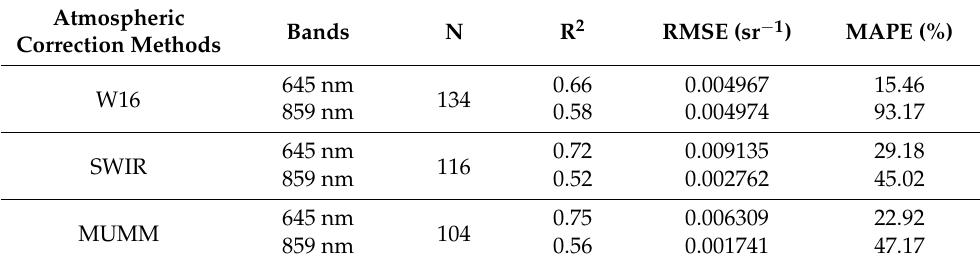
Figure 13. Comparison of three atmospheric correction methods. Table 3. Performance of three atmospheric correction methods.